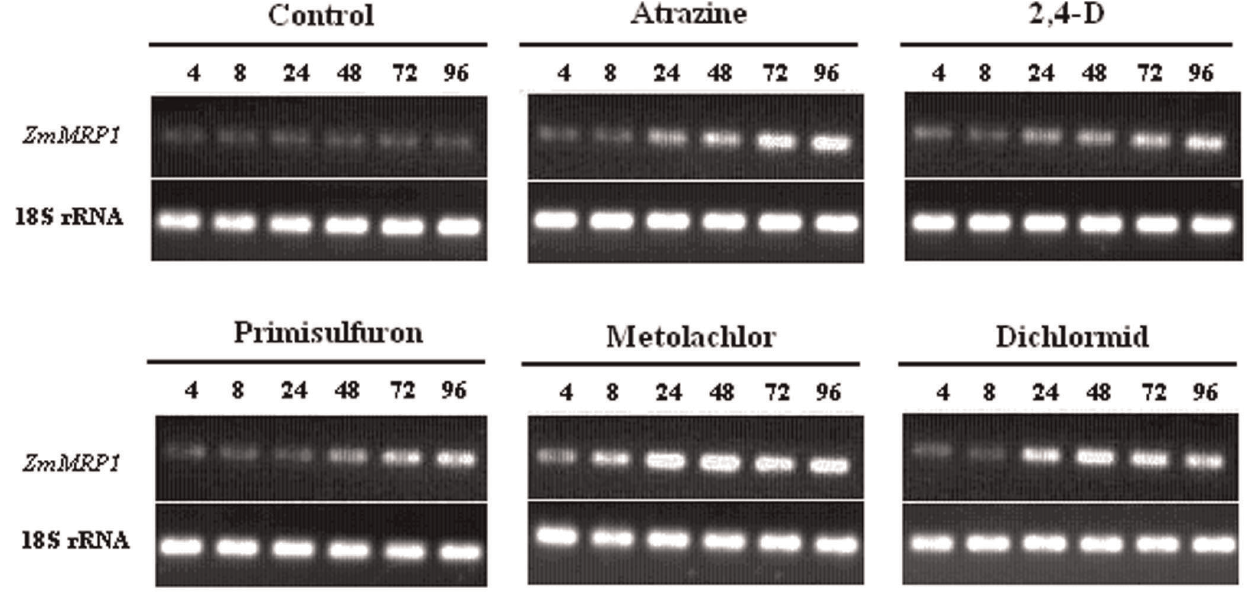
Figure 2. Semi-quantitative RT-PCR analysis of ZmMRP1 expression in maize leaves after treatment by various chemicals. The numbers (4, 8, 24, 48, 72 and 96) above each lane indicate the time intervals (h) after treatment. The experiment was repeated twice with similar results.